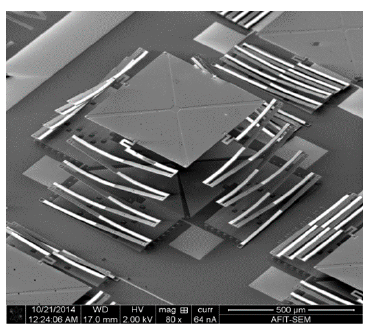
Figure 1. SEM image of current iteration of the bimorph electrostatically actuating micromirror